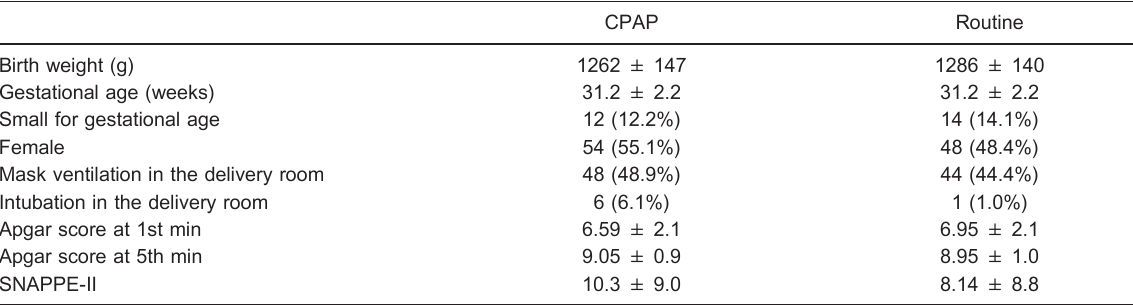
Table 2. Main characteristics of the preterm infants included in the